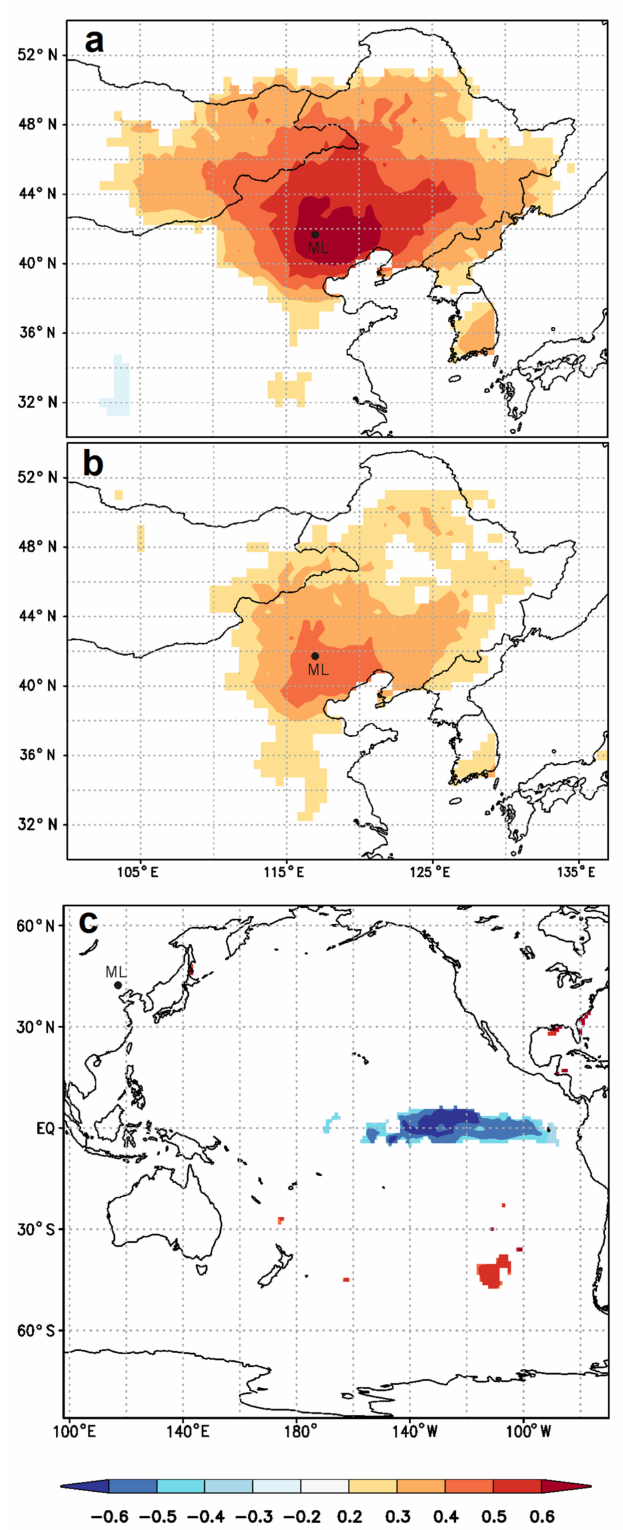
Figure 7. Patterns of field correlation ( p < 0.1). ( a ) Observed gridded mean SPEI 82 series with the gridded mean August–February SPEI (the grid system is 0.5 ◦ × 0.5 ◦ ) at the 1-month scale. ( b ) Re- constructed SPEI 82 in our study with the gridded mean August–February SPEI of the previous year. ( c ) Reconstructed SPEI 82 with the gridded the May–November HadISST1 1 ◦ reconstruction of the previous year (11-year running mean) from 1903 to 2012. The sampling site is marked by a black